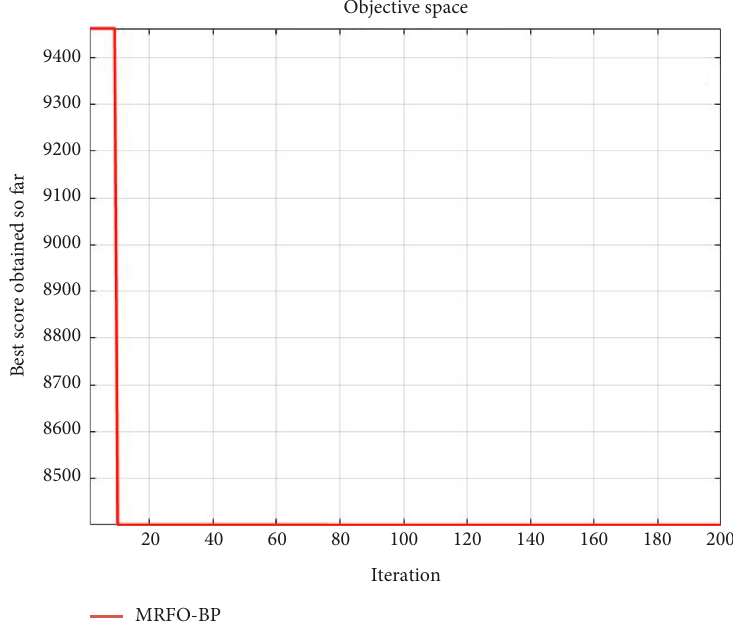
Figure 19: Historical optimal position curve of the generator (comparative experiment).